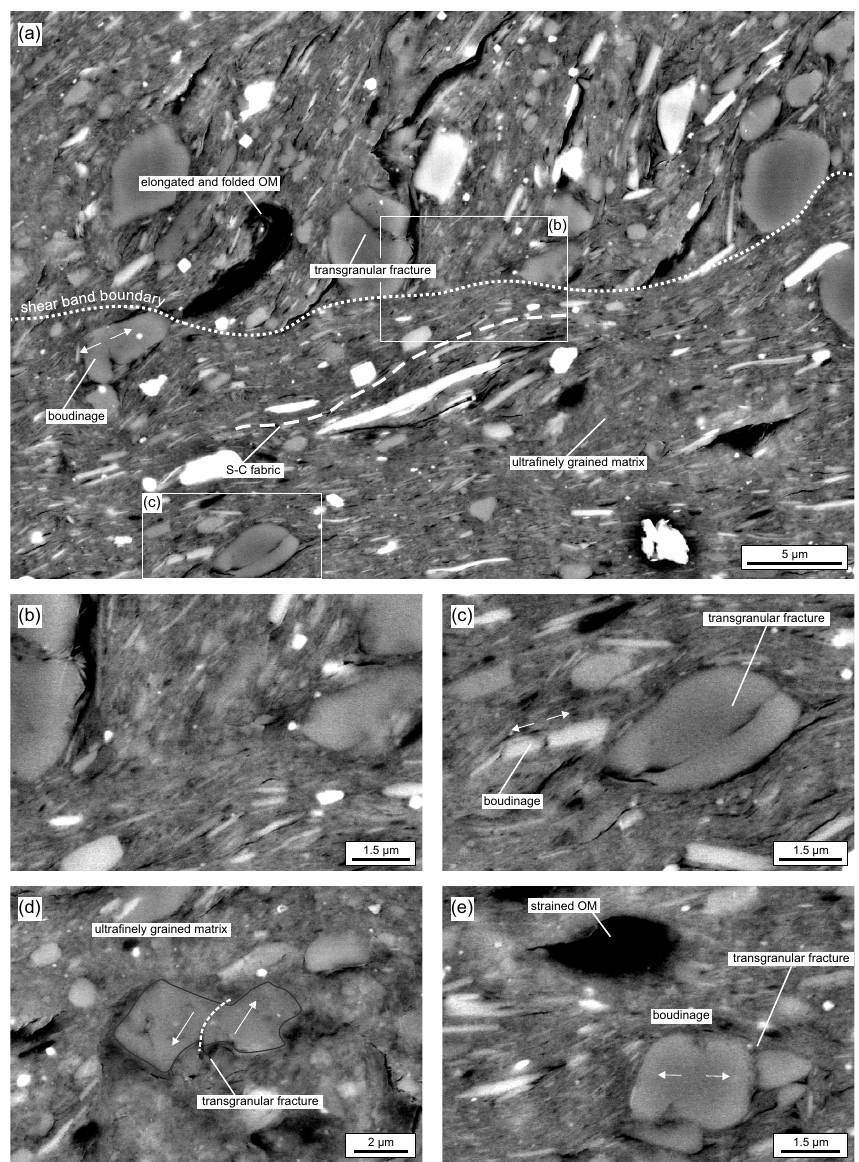
Figure 9. Details of gouge microstructure (sample V15-4; see Fig. 11a, b) with strict foliation discordance (sharp boundary of shear band to P- foliation domain), transgranular fractures, boudinage grains, strained organic material (OM), micrometer-thin shear zones (b) and ultrafinely grained matrix. All micrographs recorded with a BIB-SEM